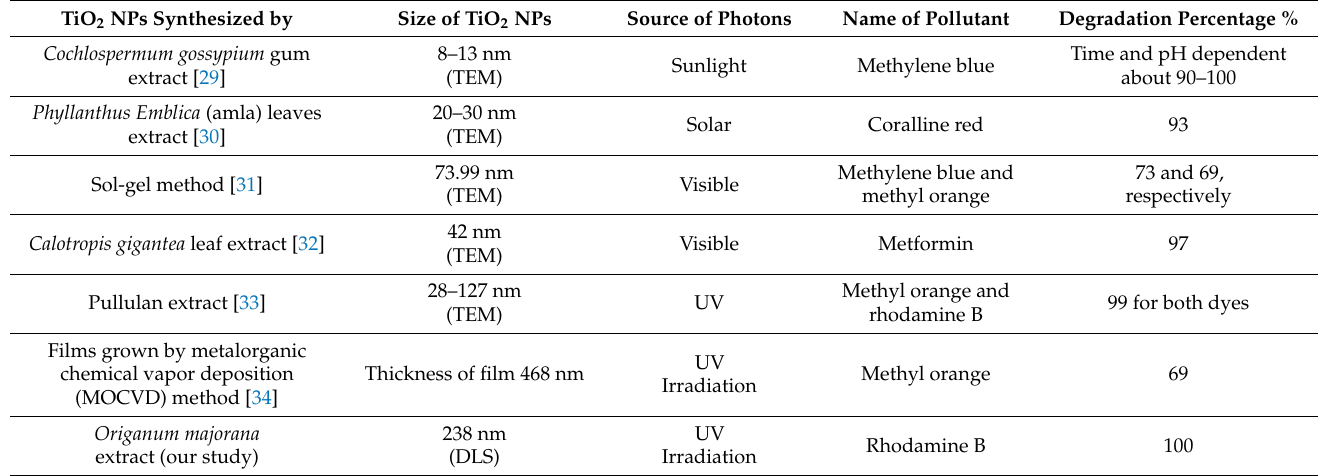
Table 1. Comparative account of published data showing performance of different